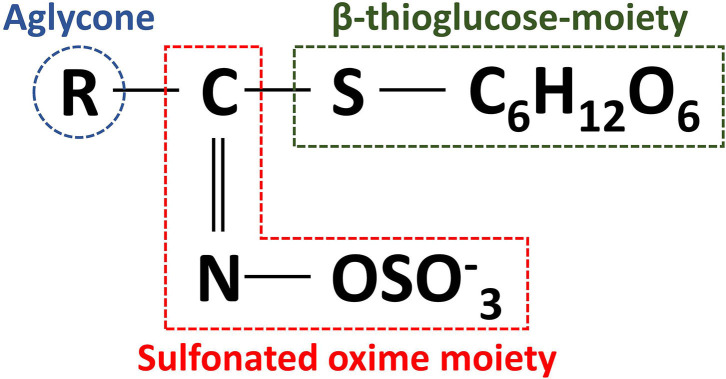
General structure of glucosinolates.